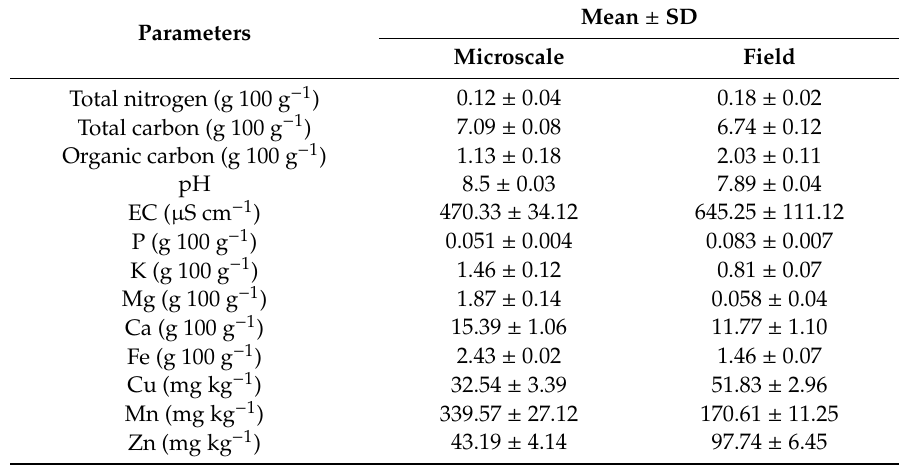
Table 5. Fertility of the soil used in the experimental analysis from the first 15 cm of soil surface. Data on total nitrogen (N), total carbon (C), and organic carbon (CO) and other macro- and micronutrients are shown. Values are means ± SD ( n = 5) at the beginning of the